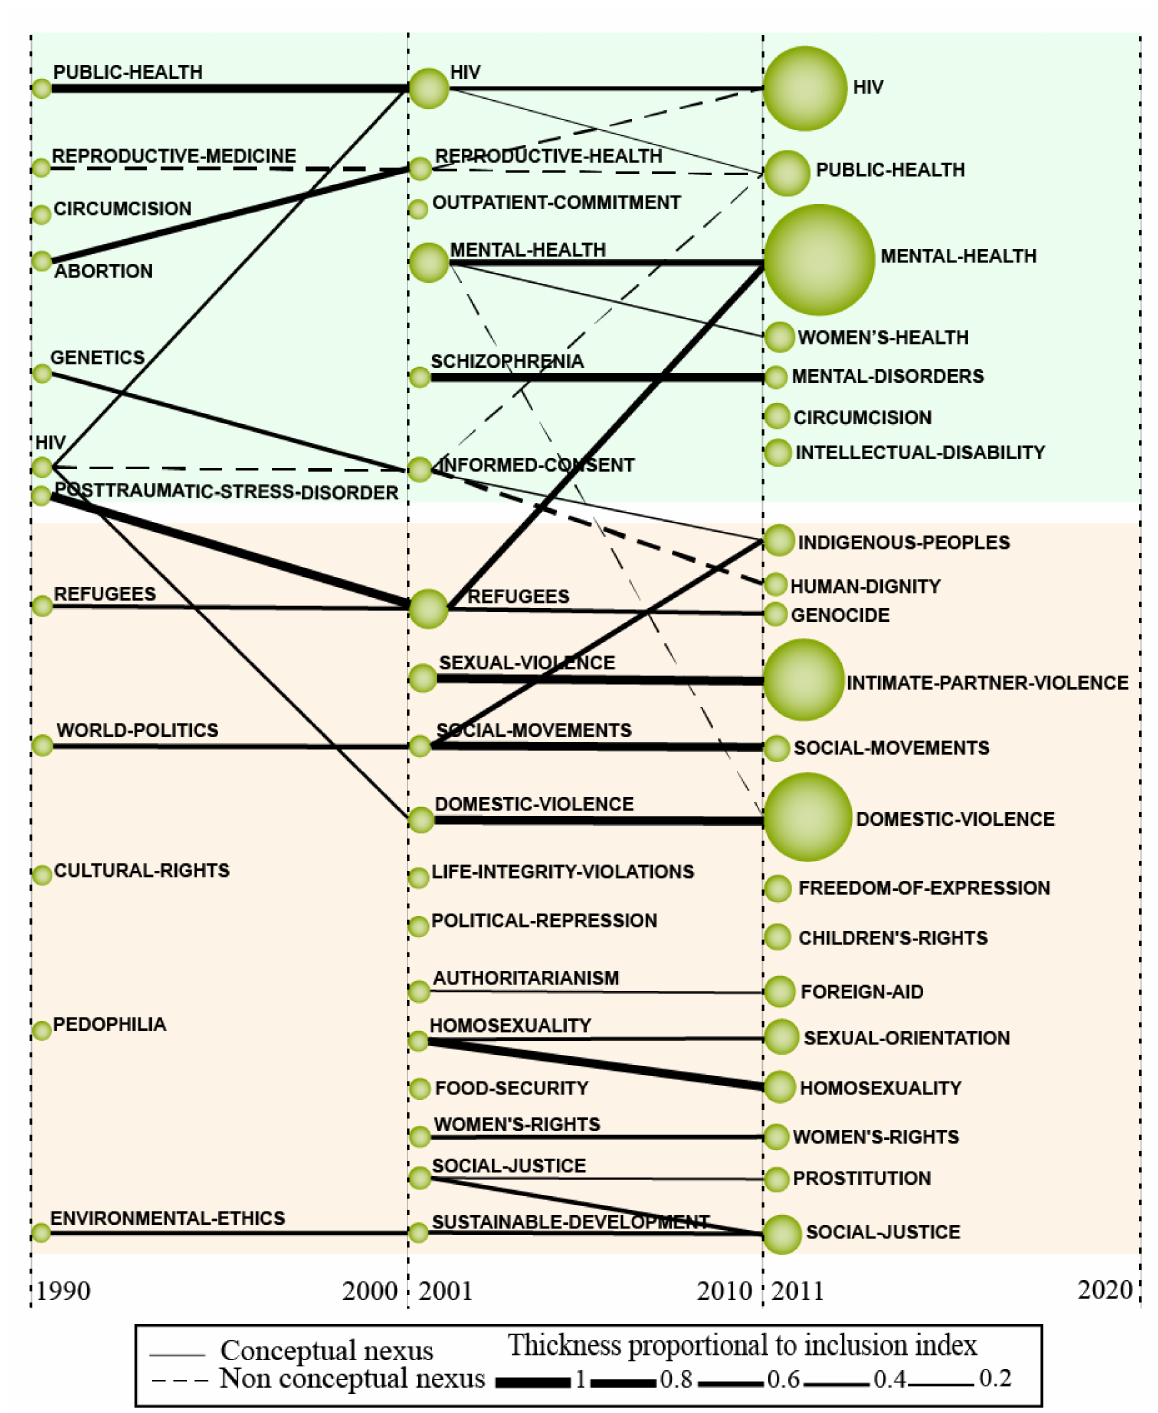
Figure 5. Thematic evolution structure of human rights study from 1990 to June